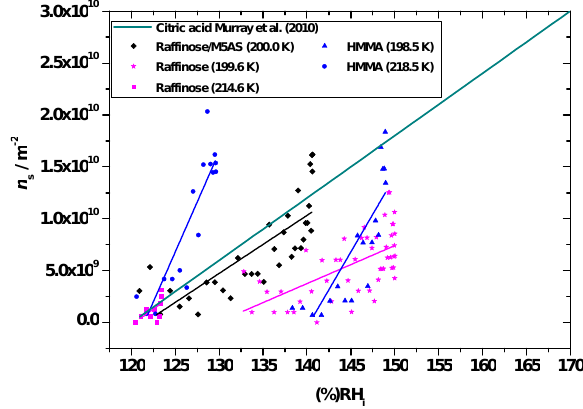
Fig. 10. The ice active surface site densities ( n s ) for glassy aerosols which nucleated ice heterogeneously (see Fig. 7). Linear fits to each dataset are shown in the corresponding colour. The solid cyan line is n s for glassy citric acid aerosol calculated using the fraction frozen parameterisation from Murray et al. (2010b) (shown in Fig. 8) and the size distribution for the aerosol used in the experiment upon which the parameterisation is based. Table 2 contains equations for linear fits to n s for aerosols from this study and glassy citric acid